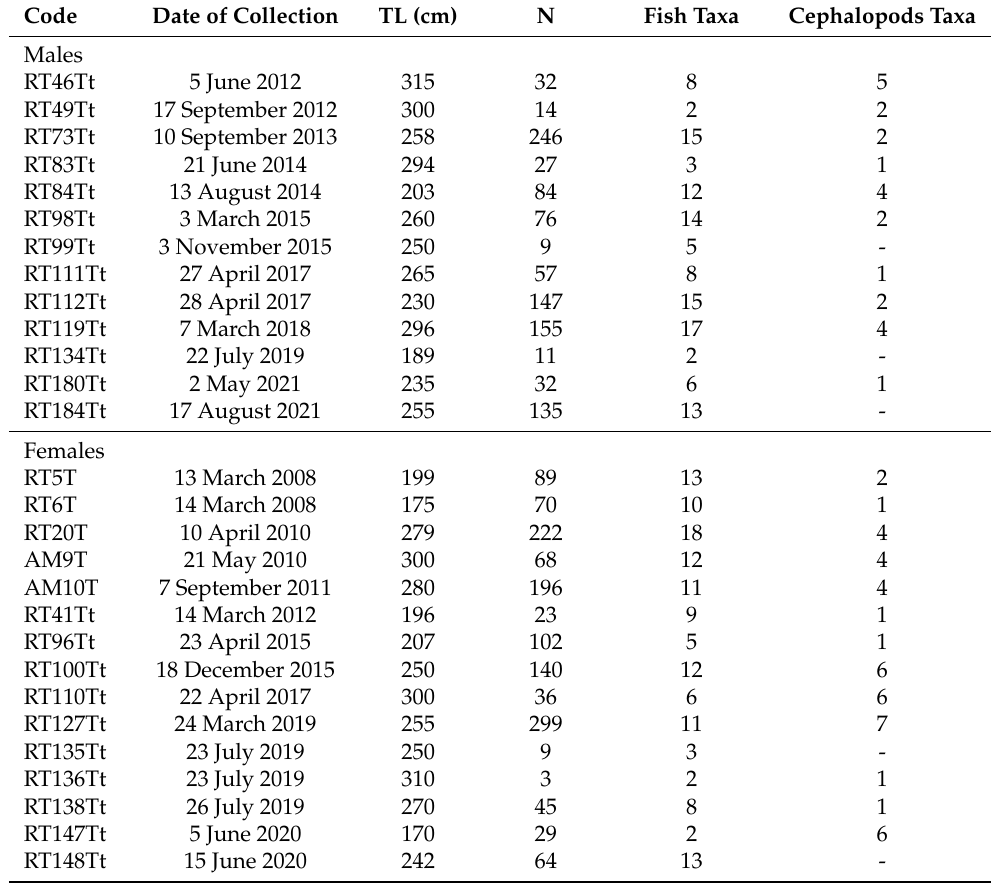
Table 1. Data of T. truncatus analyzed for dietary study. TL, total length; N, number of prey items.